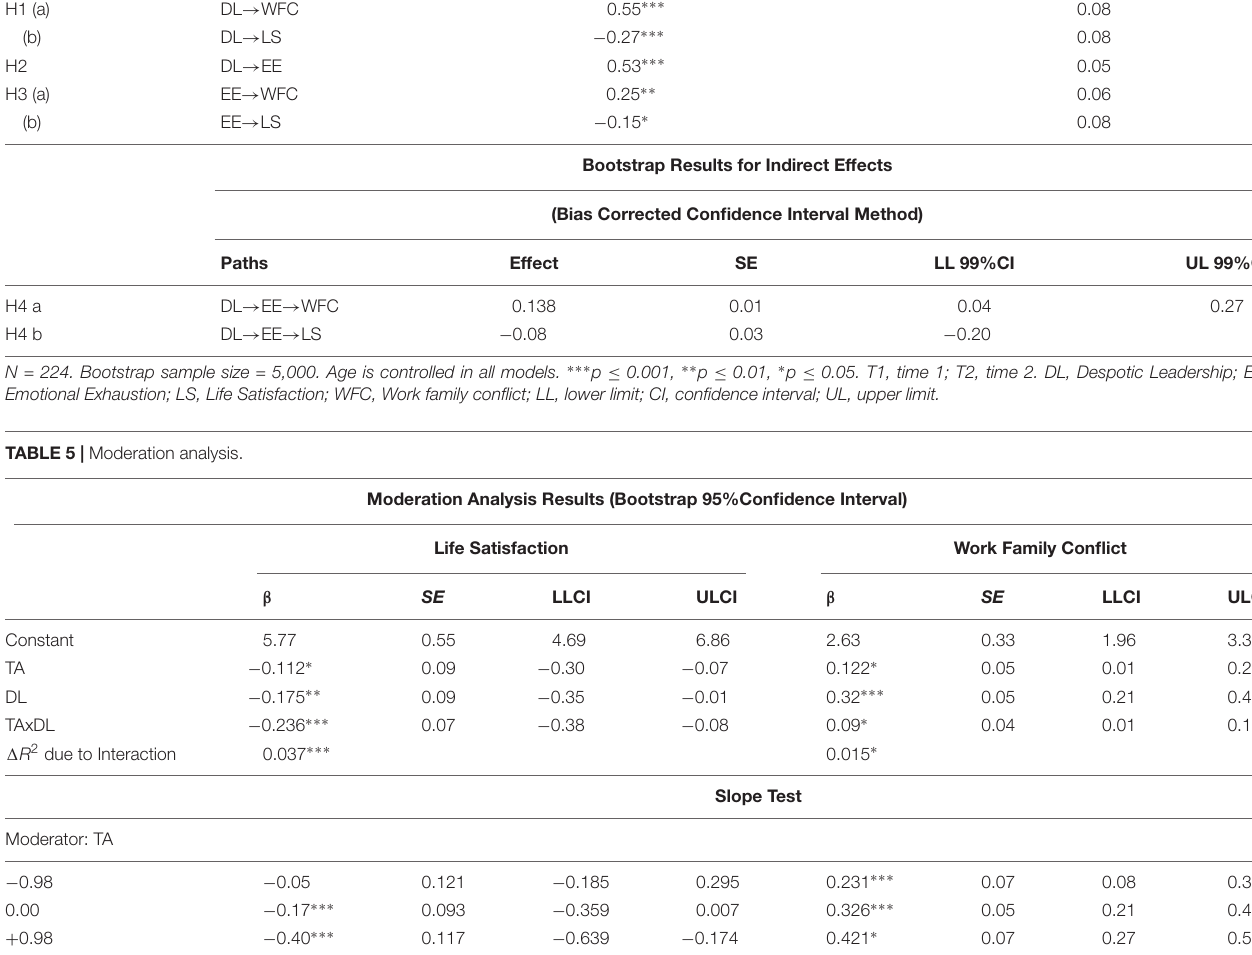
TABLE 4 | Standardized direct path coefficients of the hypothesized model. Path